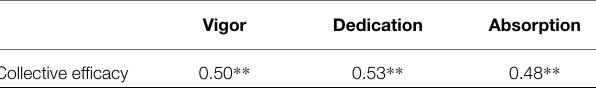
TABLE 6 | Results of Pearson Correlation between all sub-constructs work engagement and overall collective efficacy.